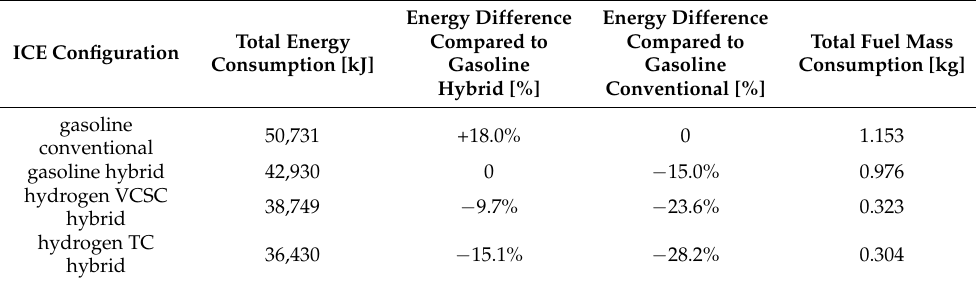
Table 5. WLTC energy and fuel mass consumption